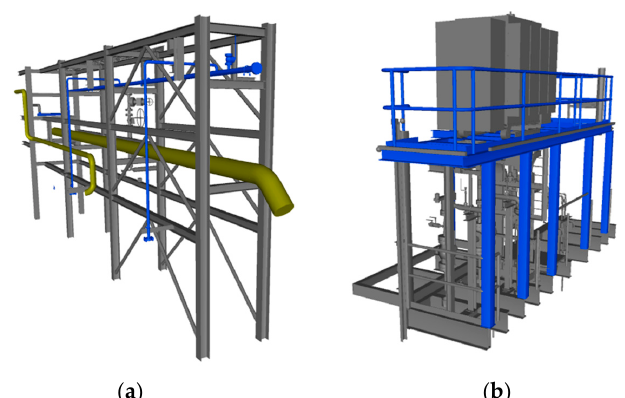
Figure 1. Typical steel frames used in offshore structures. ( a ) Pipe rack; ( b ) Mechanical Equipment Support.